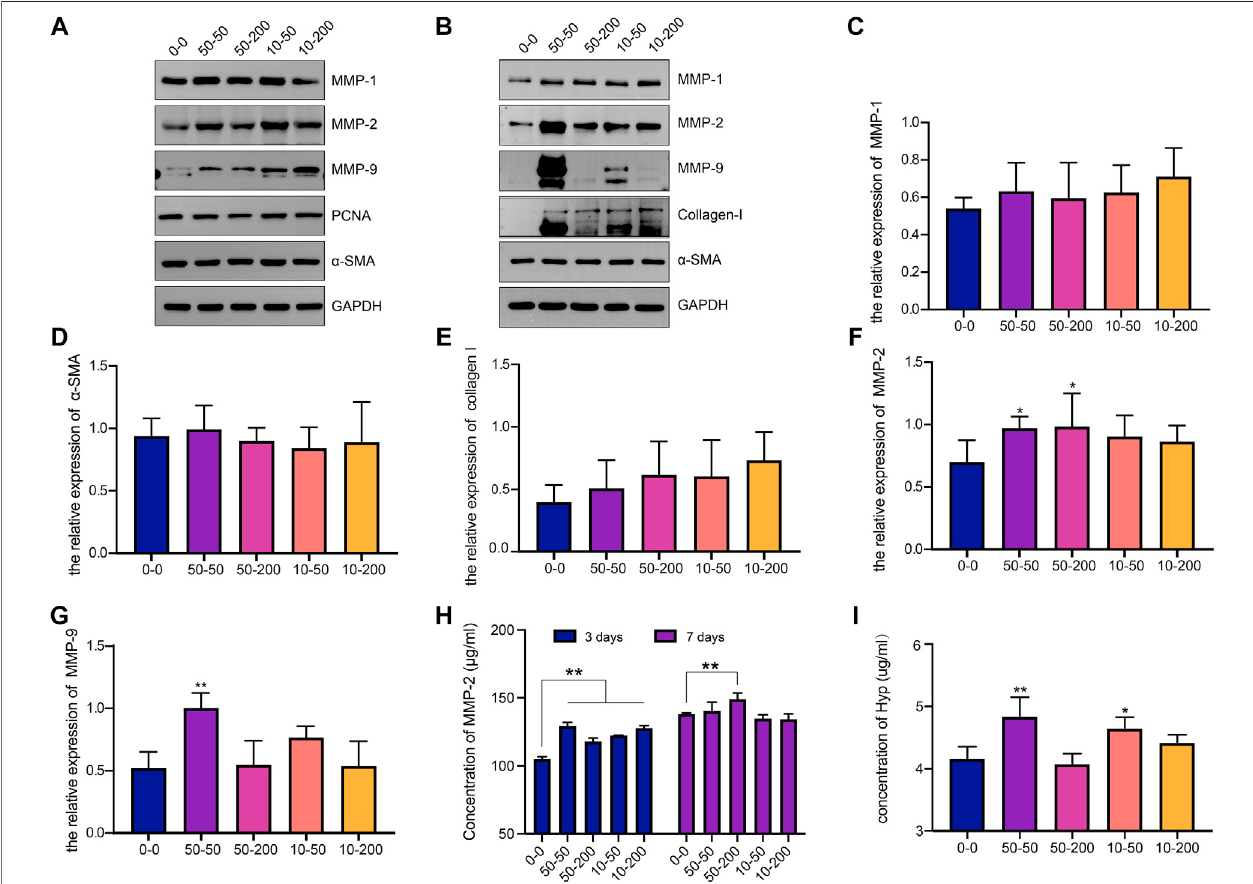
FIGURE5| Effectsofsurfacetopologyonmatrixmetalloproteinaseandcollagensecretionof fi broblast. (A) RepresentativeWBanalysisofMMP-1,MMP-2,MMP- 9, PCNA, and α -SMA protein extracts from fi broblasts cultured for 3 days on different samples. One representative blot of three is presented. GAPDH was used as the loading control. (B) Representative WB analysis of MMP-1, MMP-2, MMP-9, collagen-I, and α -SMA protein extracts from fi broblasts cultured for 7 days on different samples.Onerepresentativeblot ofthreeispresented.GAPDH wasused astheloadingcontrol. (C) The relative expression level ofMMP-1in each group. (D)